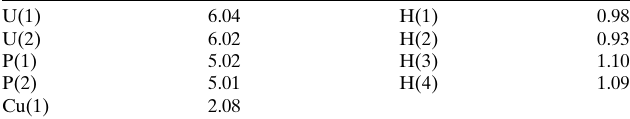
Table 3 Bond valence values ( vu ) for selected atoms in